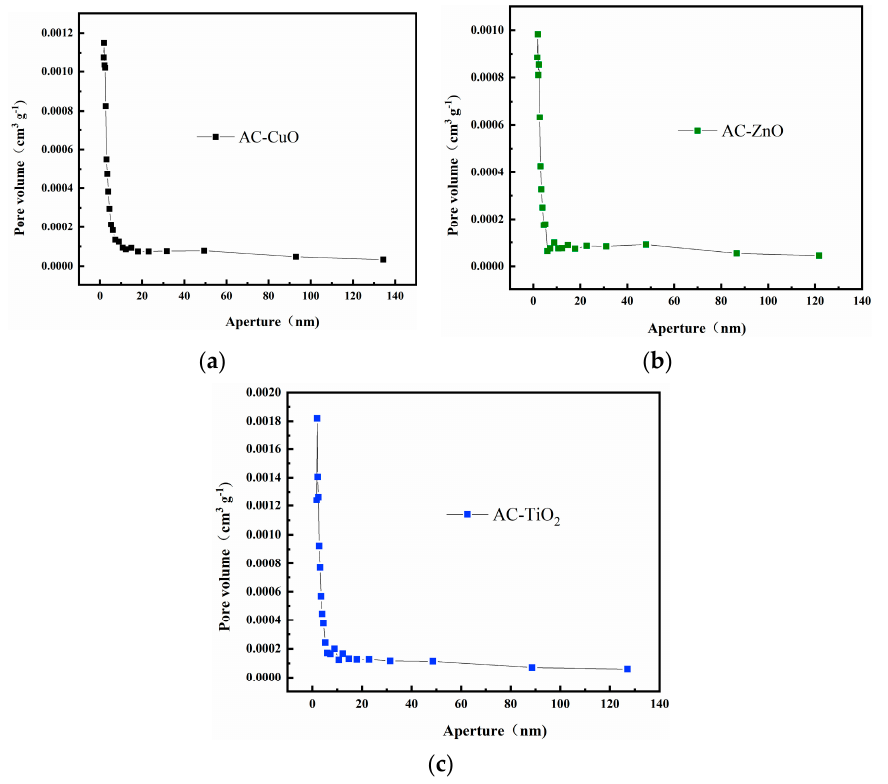
Figure 4. N 2 adsorption-desorption curves of ( a ) AC-CuO; ( b ) AC-ZnO; and ( c ) AC-TiO 2 .